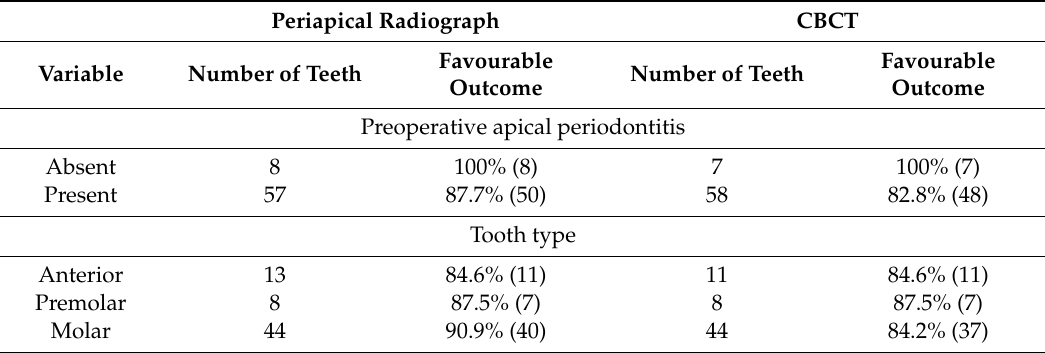
Table 2. Relationship between the outcome of root canal treatments according to preoperative variables as determined by PR and CBCT .